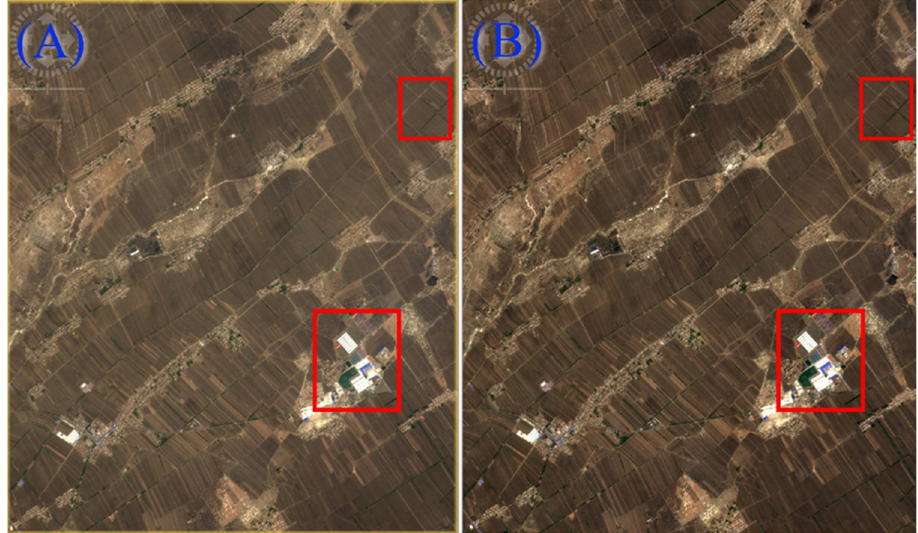
Figure 2. Sentinel image comparison before and after processing: ( A ) before image processing; ( B ) after image processing. The contrast of image resolution changes in the red box is obvious.